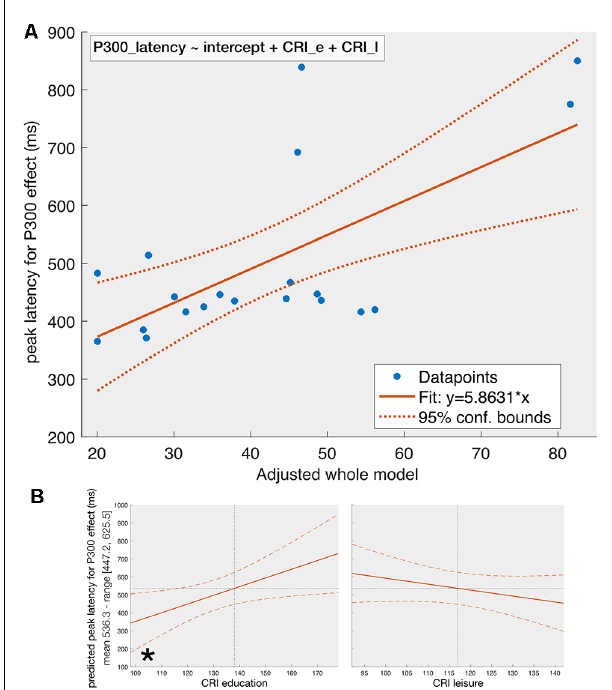
FIGURE 3 | The fit of the whole model on P300-latency (Panel A ) and the effect of individual predictors (Panel B ) given that the other predictors are constant. Panel (A) represents the dependency of the peak latency of the P300-effect on the adjusted whole model [see equation (2)] obtained from a stepwise regression with MoCA, CRI_e, CRI_w, and CRI_l, and their first level interactions as predictors. The final model contains the CRI_e and CRI_l as predictors. The solid line represents the fit of the obtained model and the dotted lines reflect the 95% confidence intervals. Panel (B) reflects the effect of individual predictors included in the model on peak latency of P300-effect given that the other predictors are kept constant. When other predictors are kept constant, CRI_e is the only significant predictor in the model, which can be explained by noting that the p -value for removal of predictors during stepwise regression was set by default to 0.1 (see the section on statistics), which is higher than the p -value we set for statistical significance (0.05). Same conventions as in Figure 2